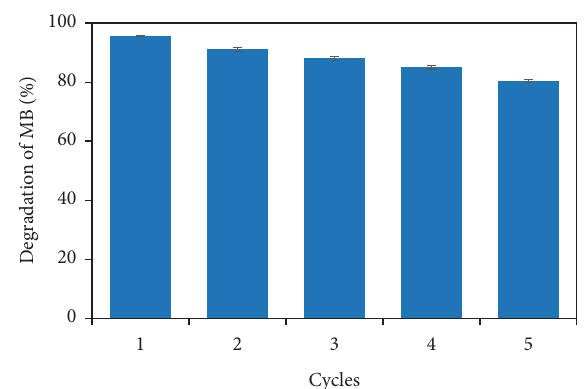
Figure 8: Reusability of CQDs in photocatalytic degradation of MB dye.